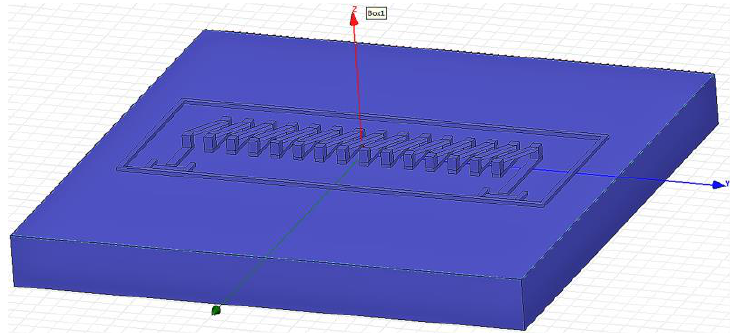
Figure 3. Coil structure model in HFSS (High Frequency Structure Simulator). The coil parameters in this model can be manually adjusted within a certain range.